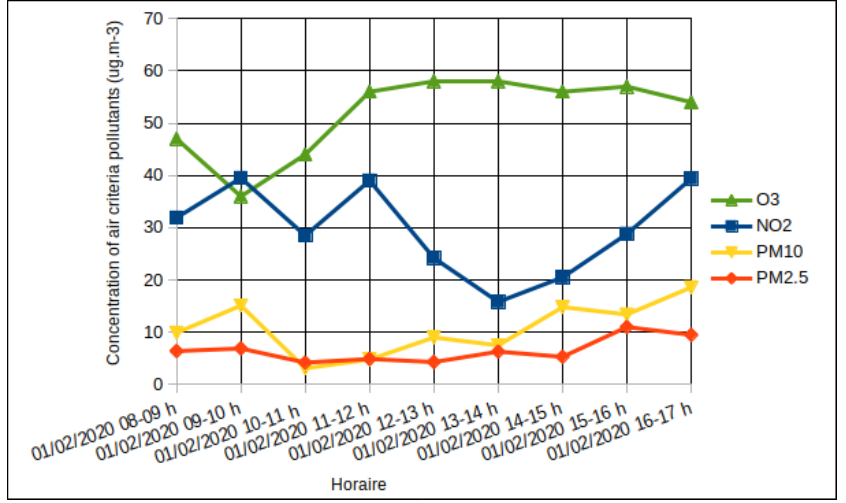
Figure 1. Evolution of pollutant concentration over